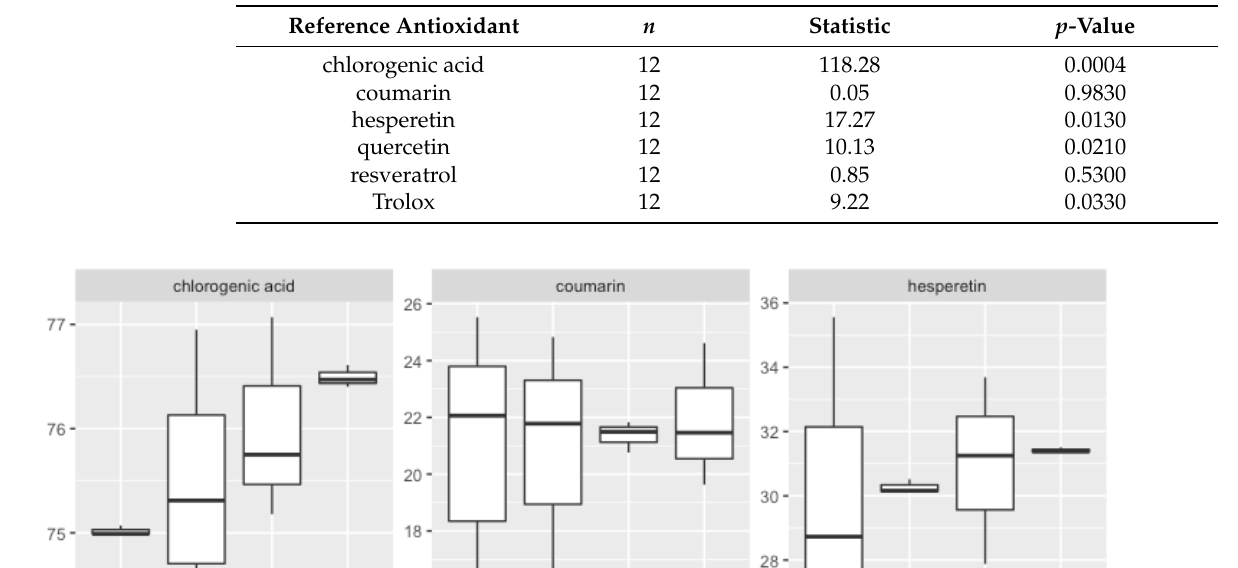
Table 3. Welch ANOVA test results for each reference antioxidant.